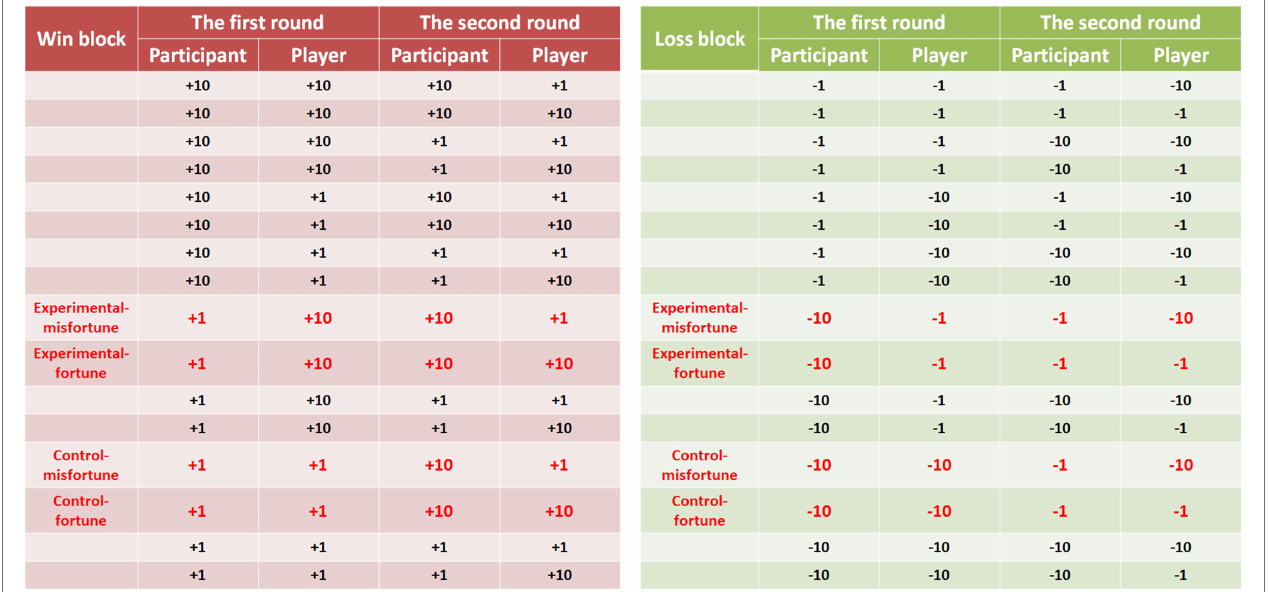
FIGURE 2 | The outcomes between the participants and players for the two rounds of the game in the win and loss block (on the left and right panel, respectively) in Experiment 1. The outcomes in red are those in the experimental and control conditions. The first round of the game is to elicit envy and non-envy emotions, and the second round is to assess the feelings of pleasure